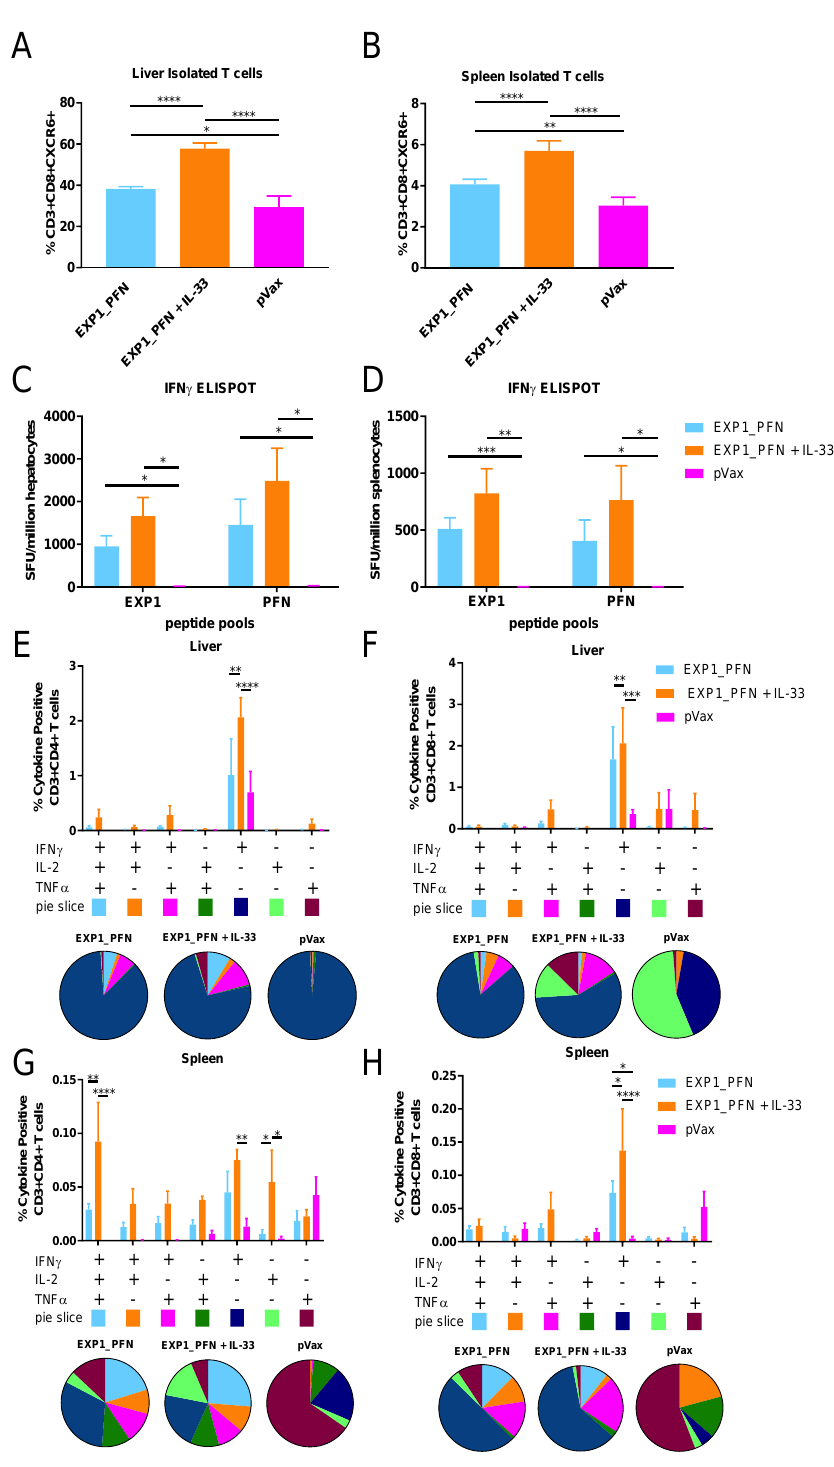
Figure 4. Synthetic DNA vaccines drive antigen-specific liver resident T cells. Mice were immunized 3 times at 3-week intervals with the EXP1_PFN vaccine construct with and without plasmid IL-33. Lymphocytes were isolated from liver and spleen 1 week after the final immunization. ( A , B ) The proportion of liver resident / homing CD8 + T cells. Lymphocytes from liver ( A ) or spleen ( B ) were stained for extracellular CXCR6 and analyzed by flow cytometry. Paired t-tests were used to compare the percent CXCR6 positivity on CD3 + CD8 + T cells across vaccine groups and against the pVax control. ( C , D ) The Py antigen-specific cellular immune response in liver ( C ) and spleen ( D ) measured by IFNγ ELISPOT. Cells were stimulated for 18 h with peptide pools encompassing the entire protein. T-tests were performed to compare IFNγ production across vaccination groups and against the pVax